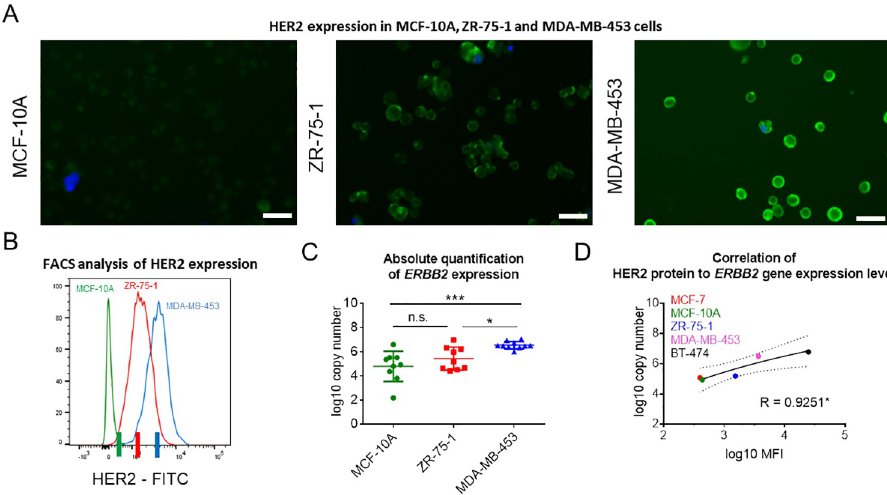
Fig 3. Highly accurate analysis of differential expression facilitated by the new qPCR assay. HER2 expression analysis in three breast cancer cell lines (MCF-10A, ZR-75-1 and MDA-MB-453) assessed microscopically (A) and by flow cytometry (B). (A) Brightness: +20%, contrast: -40%. Scale bar indicates 20 μ m. (B) Median FITC (MCF-10A) = 436; Median FITC (ZR-75-1) = 1,529; Median FITC (MDA-MB-453) = 3,575; 3.5-fold (MCF-10A vs. ZR-75-1)